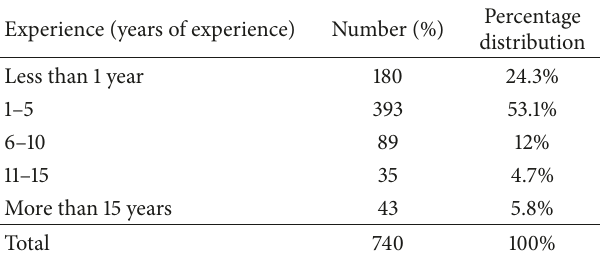
Table 2: Respondents years of